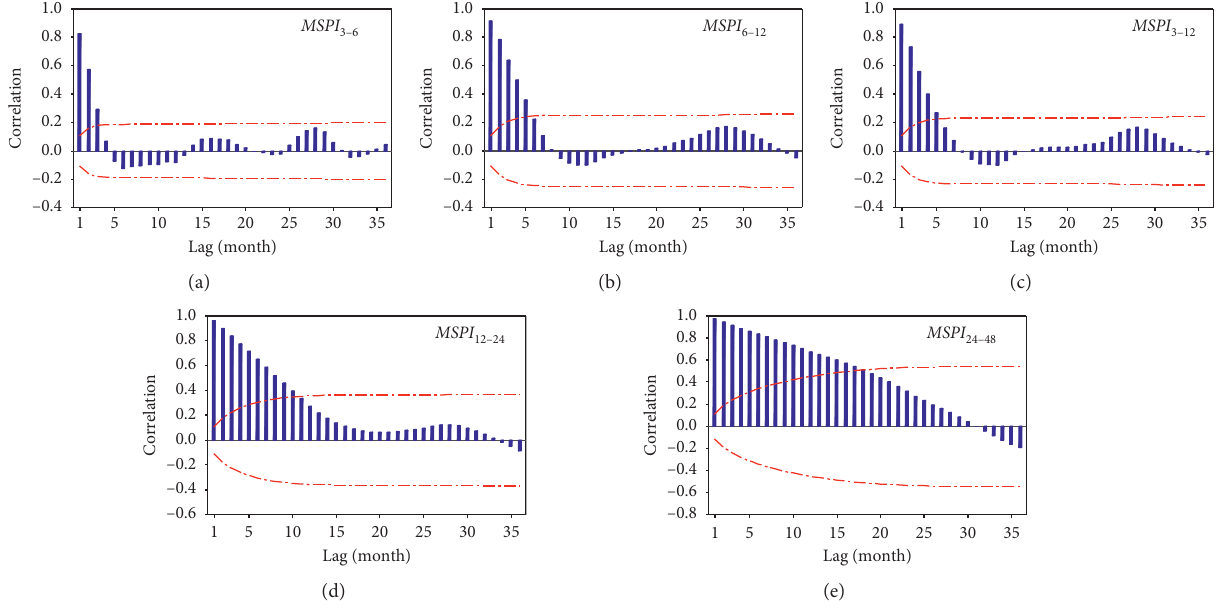
Figure 5: ACF plots of the five time windows of MSPI for Hamedan